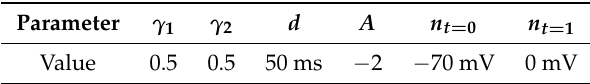
Table 1. Values of the coefficients used in Equations